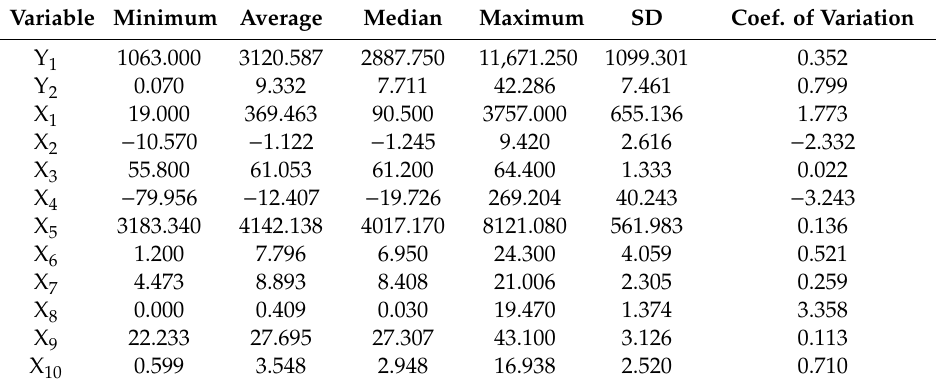
Table 2. Main descriptive statistics of the variables taken for analysis. SD = standard deviation, Coef. of variation = coe ffi cient. of variation.